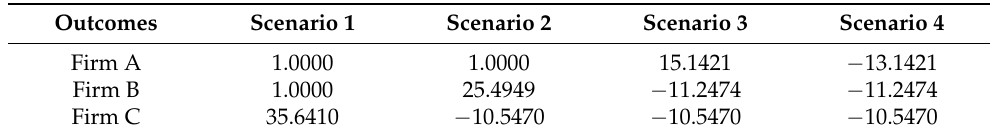
Table 10. Outcome matrix for the diverse operational risk case.